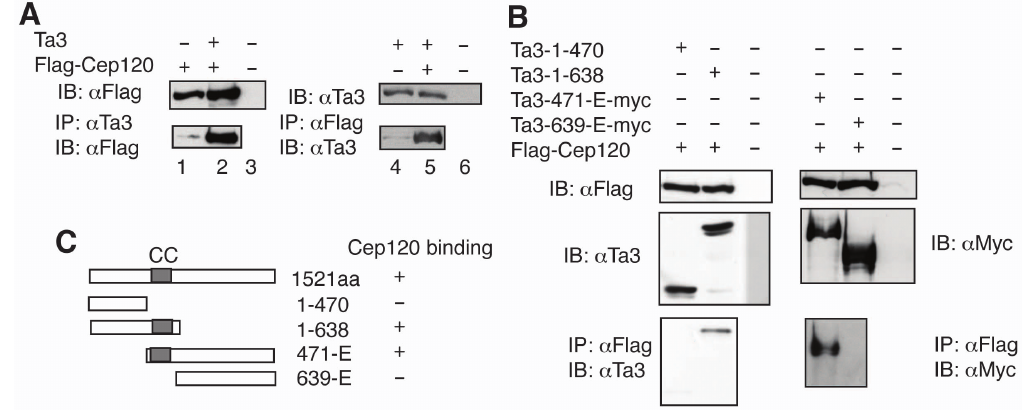
Figure 1. Ta3 interacts with Cep120 in the cell. FLAG-Cep120 was coexpressed with Ta3 (A) or various Ta3 mutants (B, C) in HEK293 cells as indicated. The protein lysates made from the cells were subjected to immunoblot (IB) or immunoprecipitation (IP) followed by immunoblot with the indicated antibodies. Note that the interaction of Cep120 with Ta3 requires the coil-coiled (CC) domain of Ta3 (B, C).